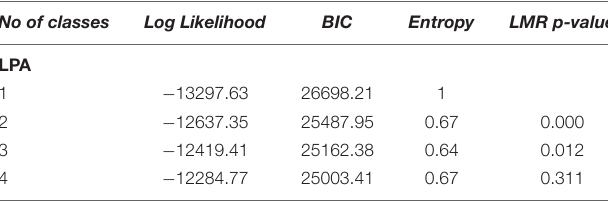
TABLE 2 | Fit information of the latent profile analysis.